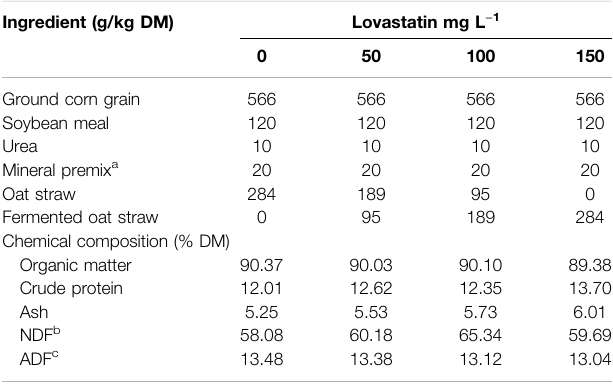
TABLE 1 | Ingredients, chemical composition, and proportions of fermented oat straw as a lovastatin-carrier additive in the experimental diets. Ingredient (g/kg